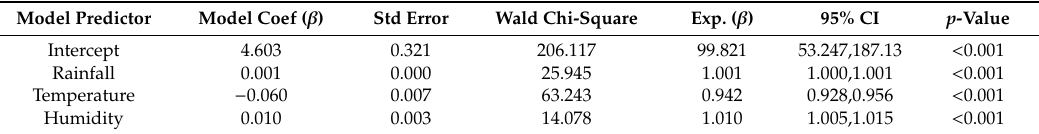
Table 1. Negative binomial regression